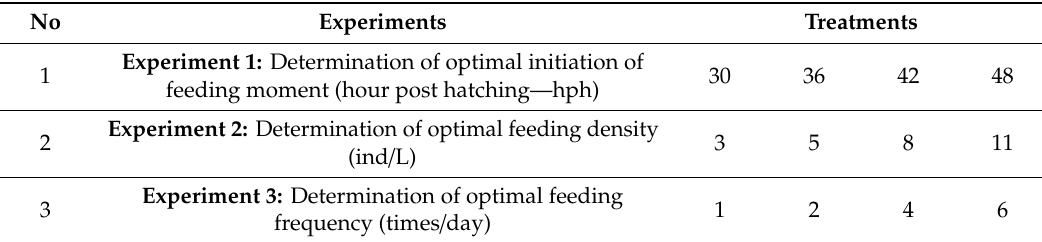
Table 1. Summary of experimental design of three